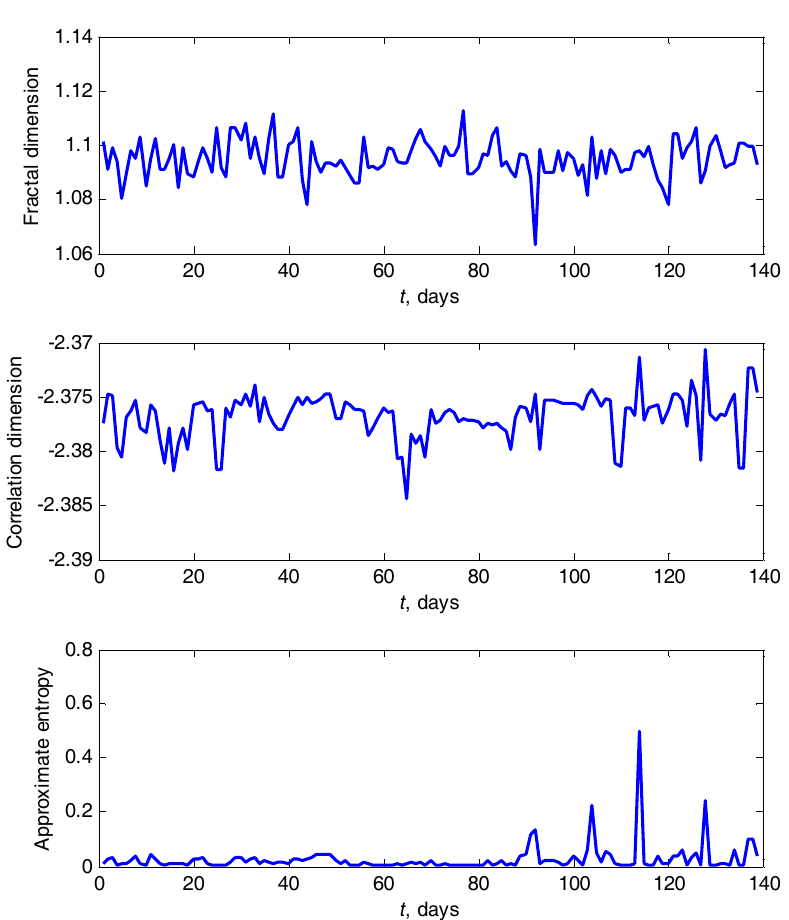
Figure 18. Fractal dimension, correlation dimension and approximate entropy features calculated from the vibration slew bearing signal.